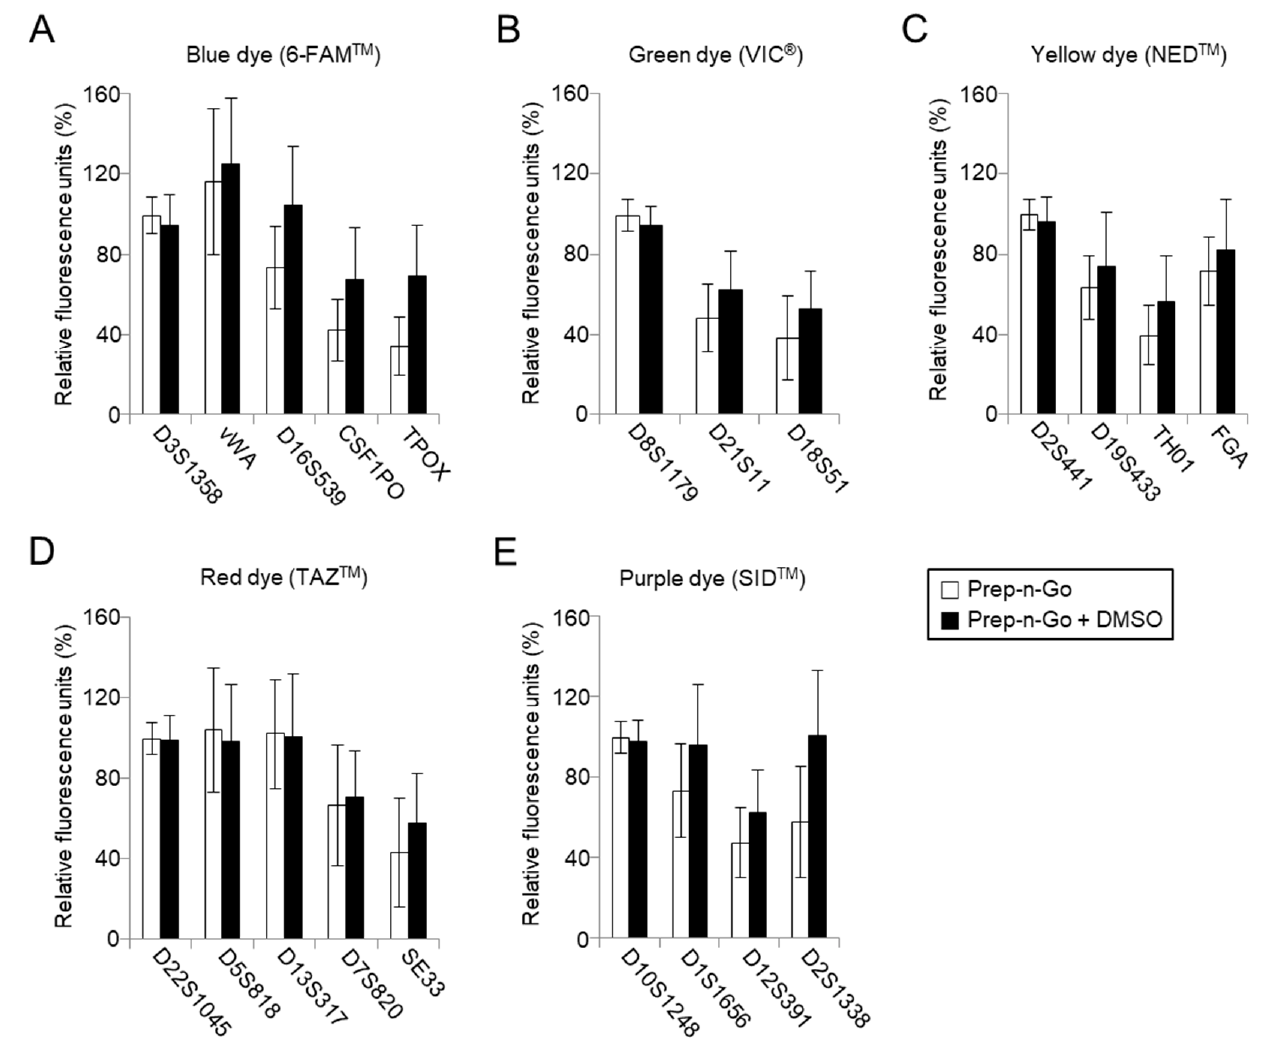
Figure 4. Reduction of ski-slope effect by dimethyl sulfoxide (DMSO) in direct polymerase chain reaction (PCR). The average relative fluorescence unit (RFU) ratio of short tandem repeat (STR) locus in each color channel was analyzed with the GlobalFiler kit using 50 Korean buccal OC card samples ( A – E ). Y-indel and DYS391 were excluded for calculation related to peak height. Data represent mean ± standard deviation. Table 1. Dimethyl sulfoxide (DMSO) improved the relative fluorescence unit (RFU) ratio of short tandem repeat (STR) genotyping in each color channel.